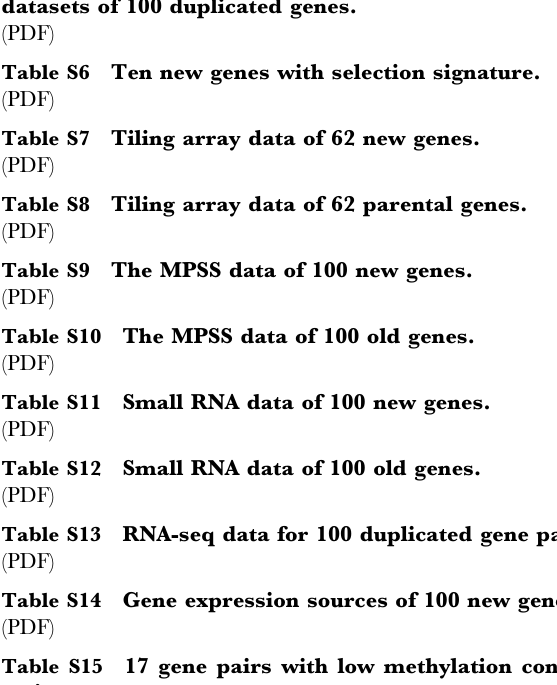
Figure S5 The EST expression profile of 30 new genes and 33 parental genes from UniGene Profile Viewer. (PDF) Table S1 137 lineage-specific duplicated genes. Table S2 Lineage-specific chimeric duplicated genes. Table S3 92 NDG branch specific Ka/Ks and back- ground Ka/Ks. Table S4 Comparison of the Ka, Ks, and Ka/Ks values between NDGs and 10 simulated duplicated gene datasets. Table S5 The population genetics statistics of 10 datasets of 100 duplicated genes. Table S6 Ten new genes with selection signature. Table S7 Tiling array data of 62 new genes. Table S8 Tiling array data of 62 parental genes. Table S9 The MPSS data of 100 new genes. Table S10 The MPSS data of 100 old genes. Table S11 Small RNA data of 100 new genes. Table S12 Small RNA data of 100 old genes. Table S13 RNA-seq data for 100 duplicated gene pairs. Table S14 Gene expression sources of 100 new genes. Table S15 17 gene pairs with low methylation conser- vation. Table S16 The different cis-motifs in the 32 gene pairs with cis-motifs available for new genes and parental genes. Table S17 Three new genes that not only switch their tissue expression specificity but also show selection